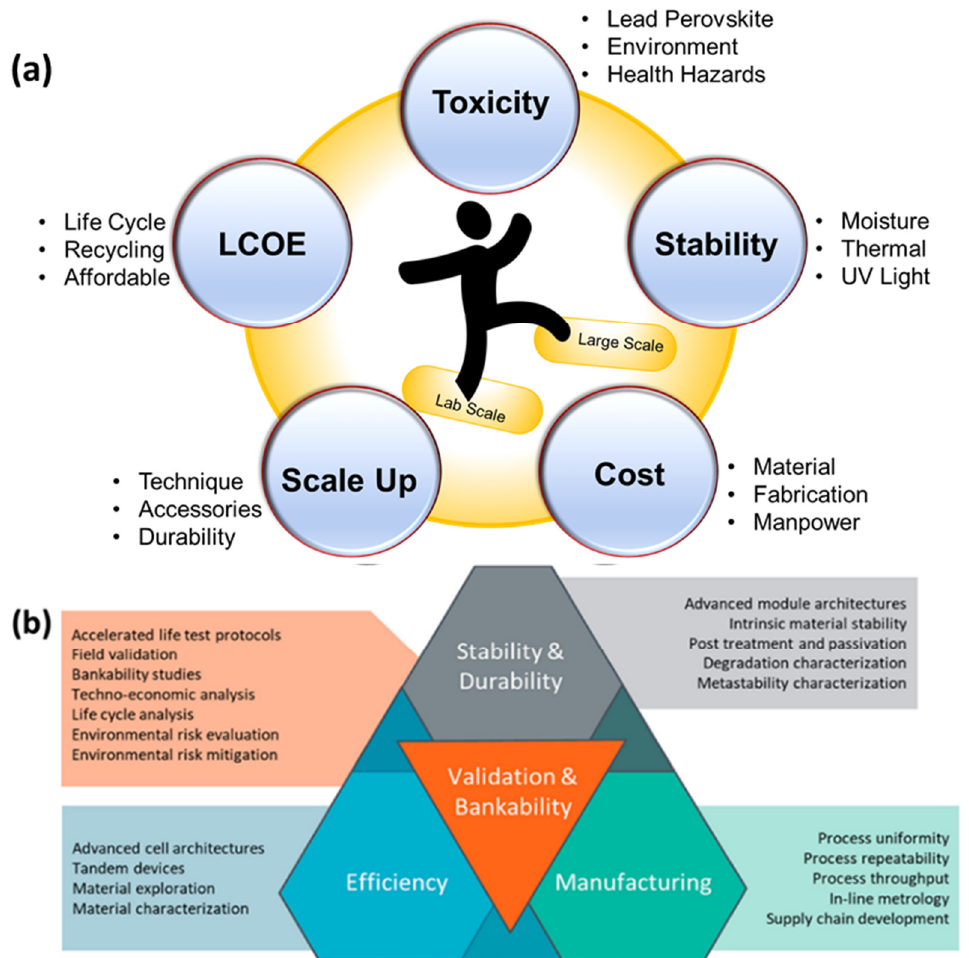
Figure 2. A schematic illustration of ( a ) factors in upscaling the manufacture of PSC devices and ( b ) technical challenges for commercializing PSCs [46].